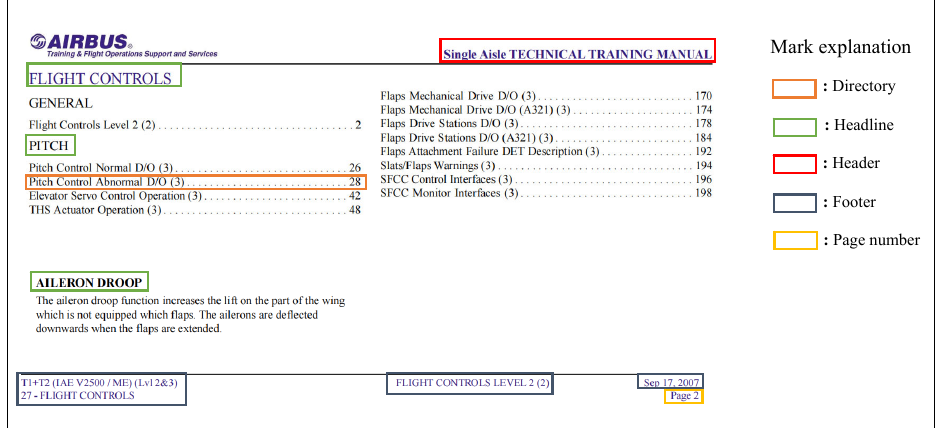
Figure 2. An example of texts that are considered